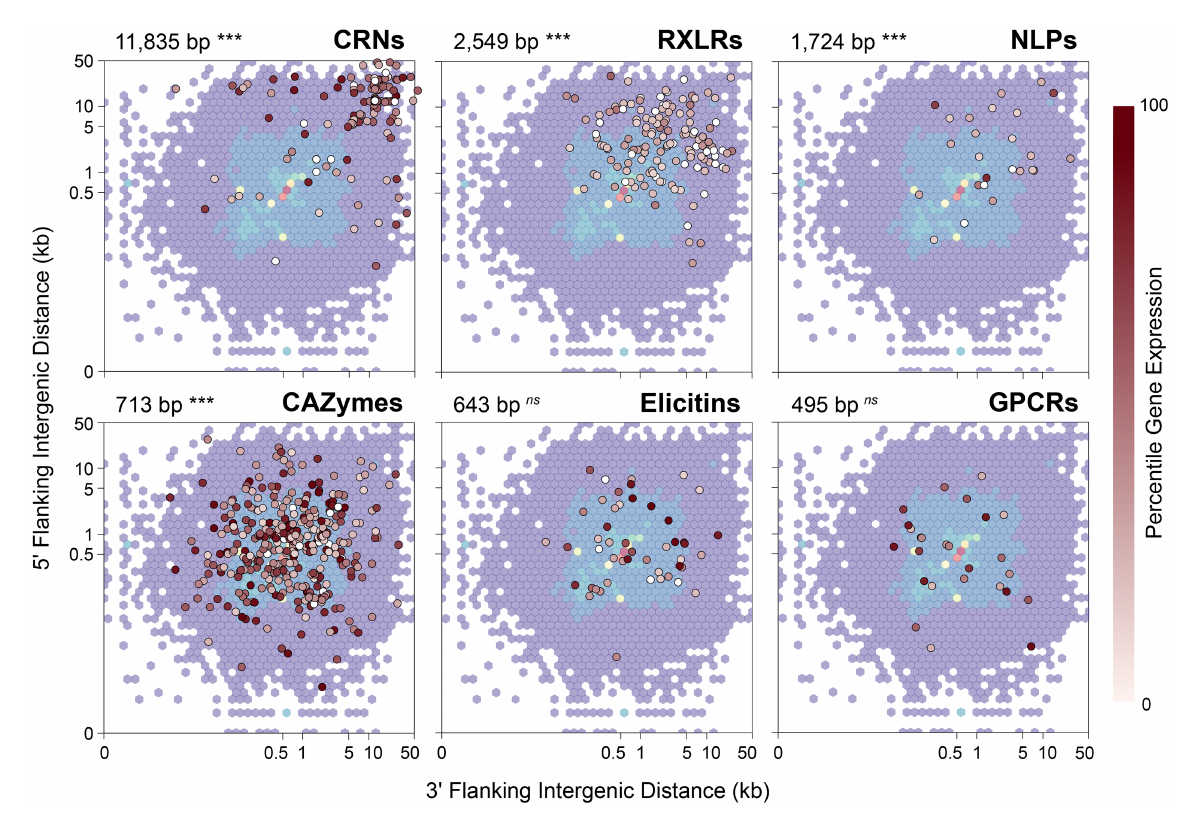
FIGURE 4 5 ′ and 3 ′ distances to the nearest gene in the Phytophthora agathidicida genome. 5 ′ and 3 ′ distances for all genes identified in the P. agathidicida 3770 genome are shown by the background density distribution, which is overlaid in each panel with intergenic distances for genes in six gene classes: RXLRs, CRNs, NLPs, CAZymes, elicitins and GPCRs. Points for individual genes are colored by their percentile expression level in culture, with no expression indicated in white, low expression by lighter reds and high expression by darker reds. The median intergenic distance and its statistical significance are also shown for each gene class. *** p < 0.001; ns, not